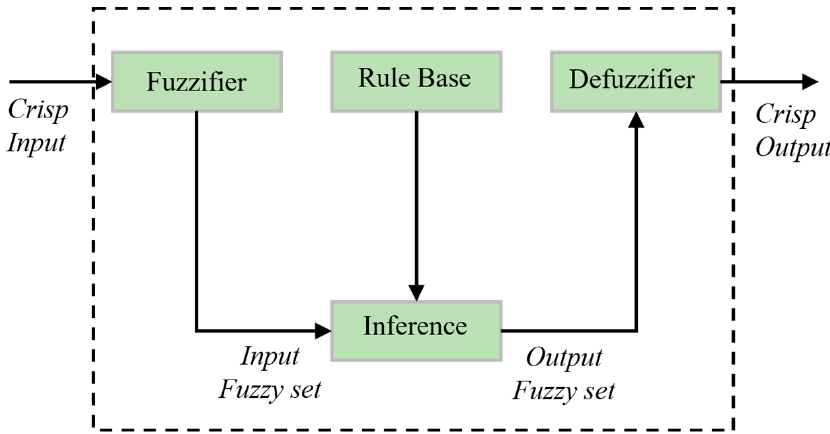
Figure 8. Fuzzy control system block diagram [26]. Reproduced with permission from Choi, S.-B. et al. State of the art of control schemes for smart systems featuring magnetorheological materials; published by Smart Materials and Structures, 2016.